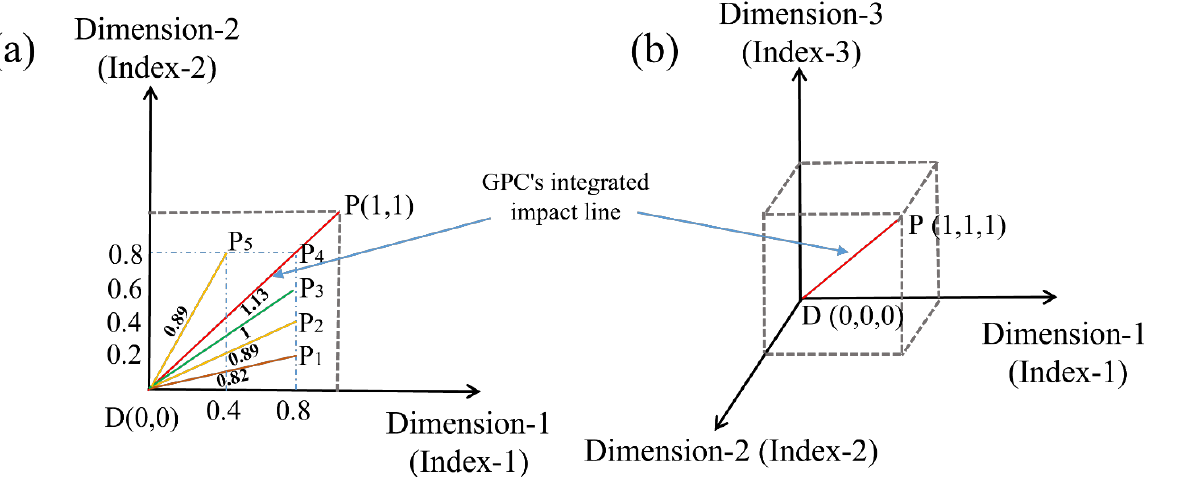
Figure 2. Schematic diagram of Euclidean distances in ( a ) a two-dimensional plane and ( b ) a three- dimensional space. The red line represents the distance between points D and P.